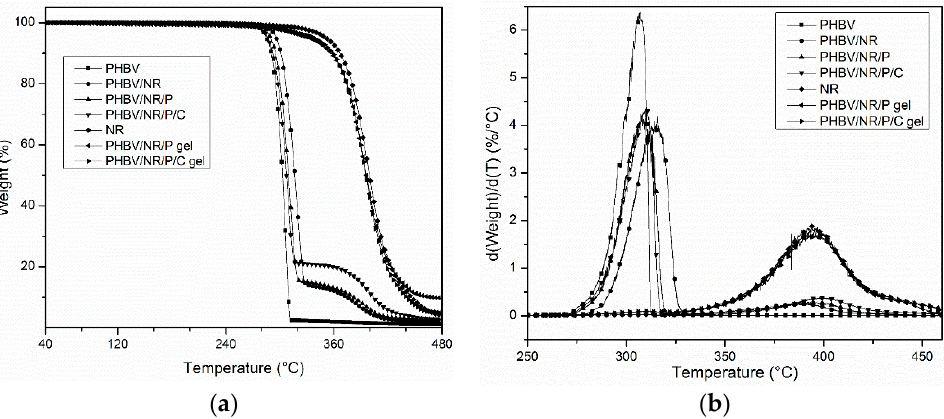
Figure 6. ( a ) Weight loss TGA thermograms; ( b ) Derivative weight loss TGA thermograms of pristine PHBV, pristine NR, blends of PHBV and NR, and the gels from PHBV/NR/P and PHBV/NR/P/C. Table 4. Melting, crystallization, glass transition, peak thermal degradation temperatures and degree of crystallinity of PHBV and NR and the blends determined from 2nd heating and 1st cooling of DSC at 10 ◦ C min − 1 , respectively. Sample